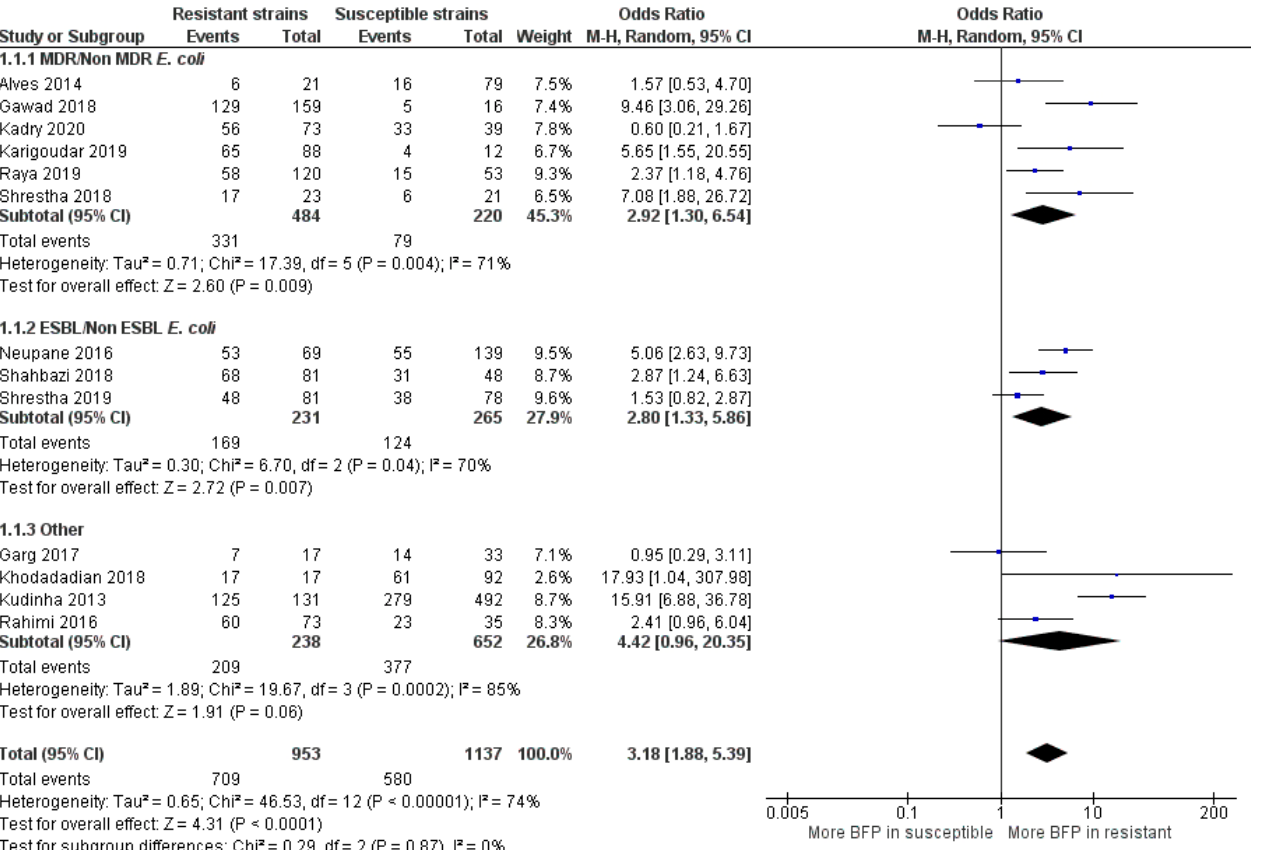
Figure 9. Forest plot of BFP prevalence in Resistant vs. Susceptible strains—UTIs (Urinary Tract Infections). “Tau 2 ” represents the absolute value of the true variance (amount of heterogeneity). “Chi 2 ” is the chi-squared test of the null hypothesis that there is no heterogeneity. “df” are degrees of freedom. “P” represents the p -value. The “I 2 ” statistic describes the percentage of variation across studies that is due to heterogeneity rather than chance. “Z” is the z-statistic, which are significance tests for the weighted average effect size. “CI” stands for confidence interval. “M-H” is the Mantel-Haenszel analysis method.